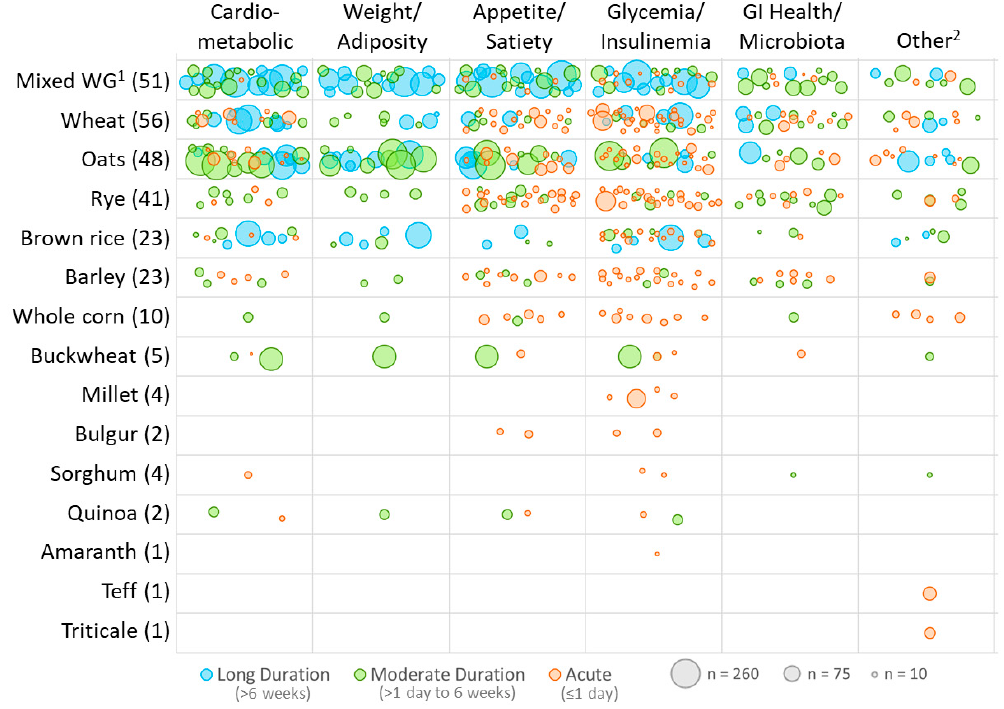
Figure 3. 1 Each bubble represents a single publication within each grain by outcome category and the size corresponds to the study sample size; position of bubbles is random within each cell; trial bubbles are duplicated between outcome or grain categories when >1 outcome of grain type was studied; 1 Mixed Whole Grain (WG) group includes combinations of 2 or more WGs, WG diets and unspecified WG foods (ex: WG bread); 2 Other outcomes include exercise performance, micronutrient status, clinical blood and urine measures and other